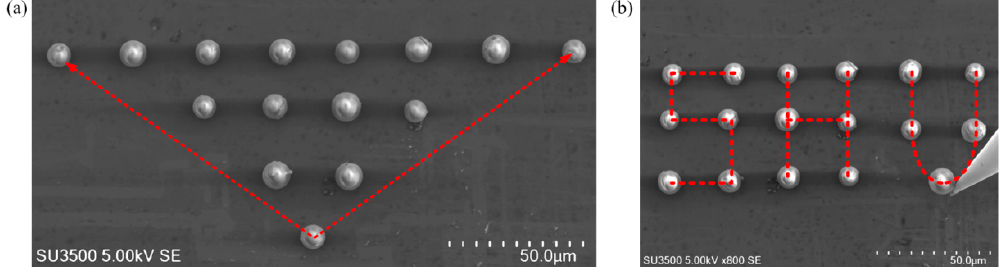
Figure 7. Well organized patterns by the proposed strategy. ( a ) A triangular microparticle matrix. ( b ) A ‘SHU’ microparticle matrix.